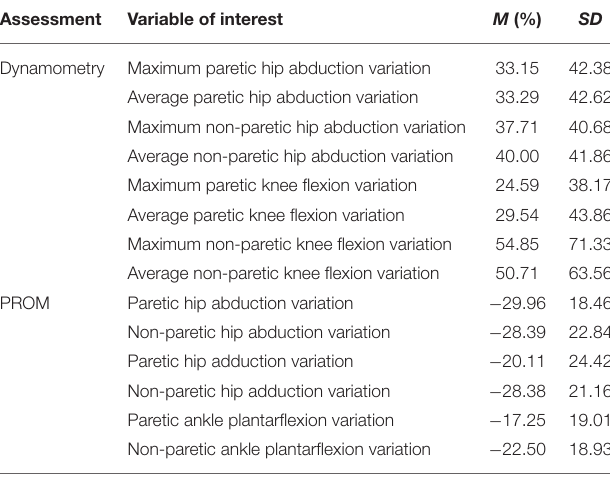
TABLE 2 | Changes in dynamometry and